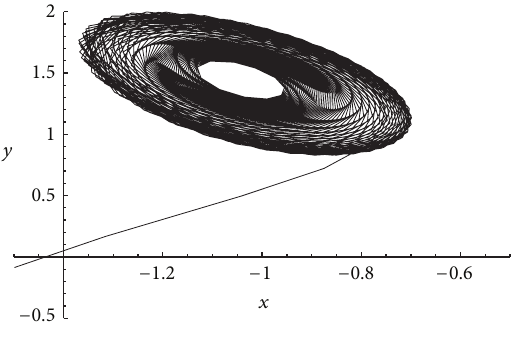
Figure 5: Solution 𝑥(𝑡) for 𝛼 = 0.96 .